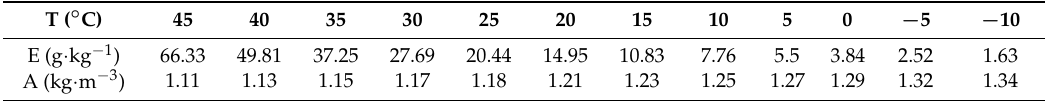
Table 2. Relationship between air temperature (T), saturation mix ratio (E), and air density (A)